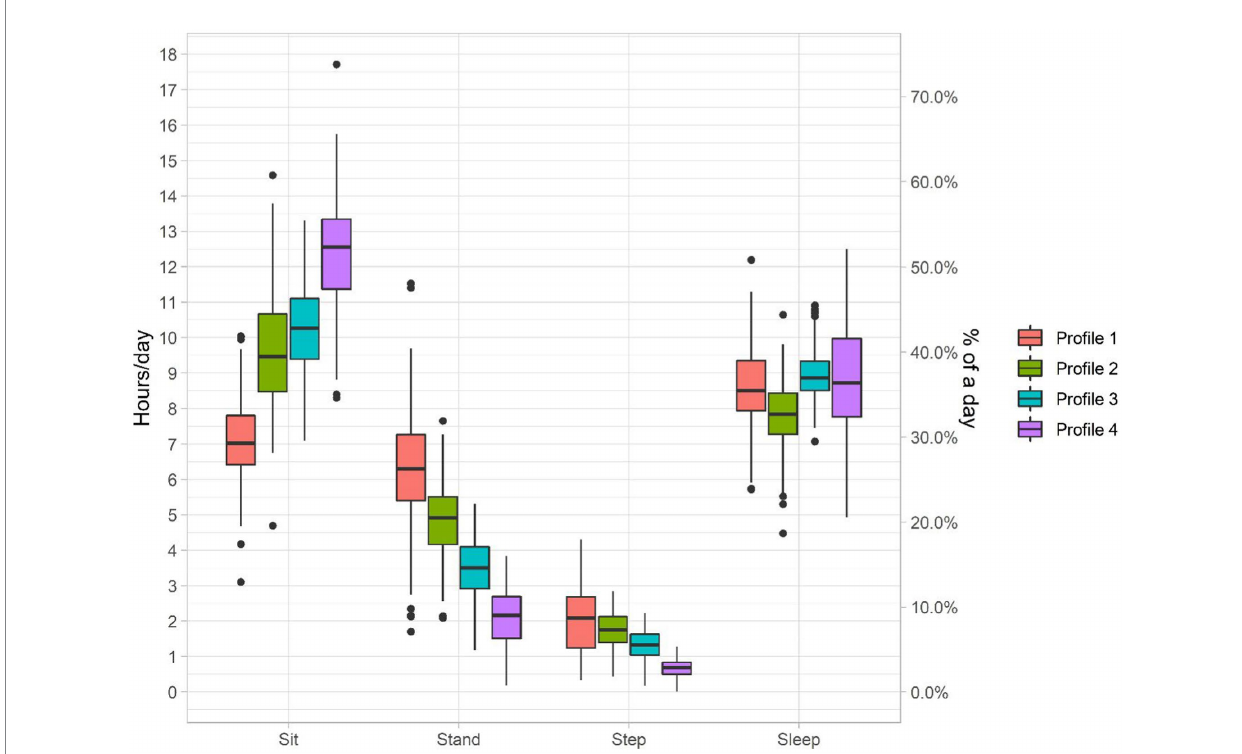
FIGURE 4 Fitted 24HAC profiles from latent profile analysis (4-class solution), where each individual is assigned the class with maximum probability. The boxplots presents sample quartiles ( N = 1034). The number (%) of subjects in profile 1–4 is, respectively, 132 (12.8%), 257 (24.9%), 453 (43.8%) and 192